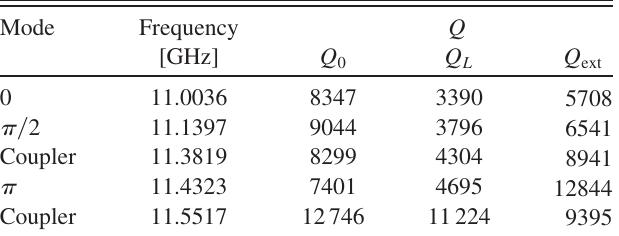
TABLE V. Table of measured Q values for PBG structure